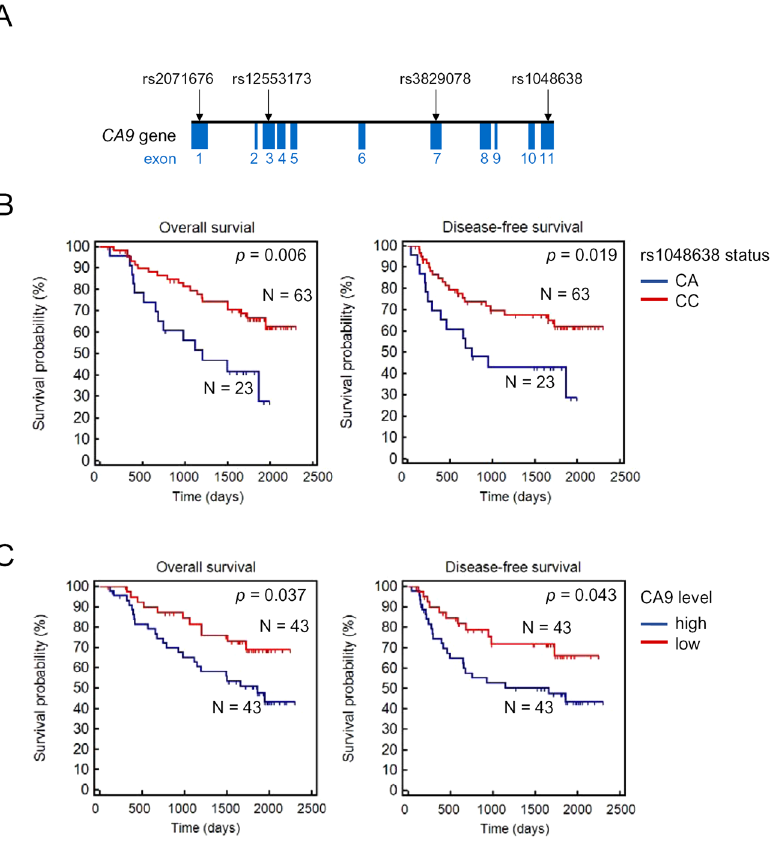
Figure 1. Association of rs1048638 with survival of hepatocellular carcinoma (HCC) patients. ( A ) Schematic illustration of CA9 single-nucleotide polymorphisms (SNPs) evaluate in HCC. ( B ) Kaplan-Meier analysis of the correlation between rs1048638 genotypes and overall survival (OS) and disease-free survival (DFS) of 86 HCC patients. ( C ) Kaplan-Meier analysis of the correlation between CA9 expression levels and OS or DFS of 86 HCC